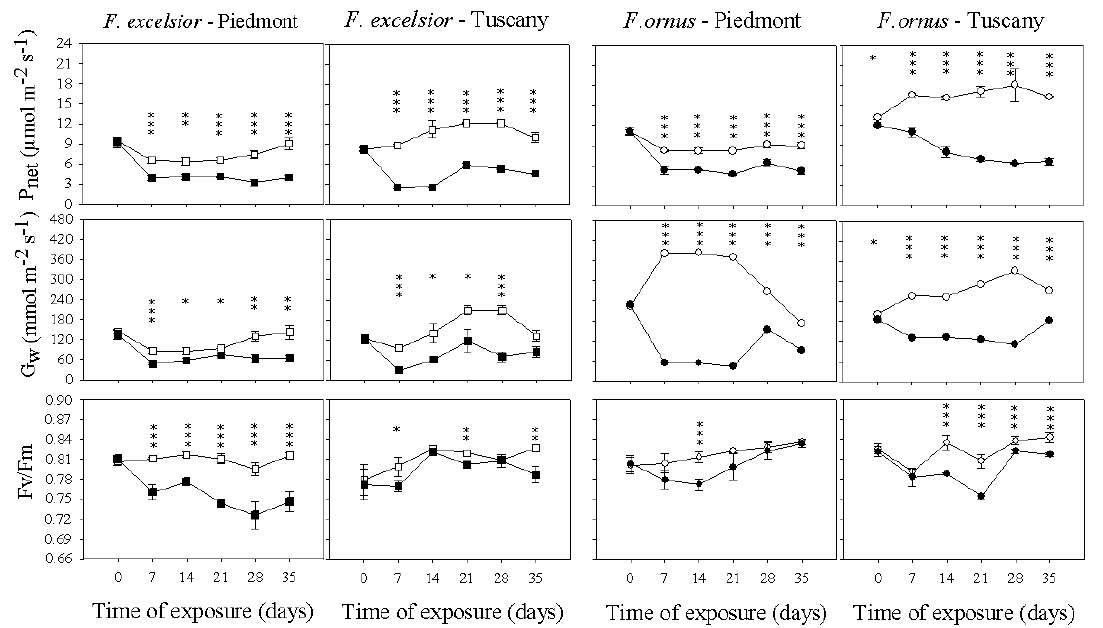
FIGURE 1 . Effects of ozone exposure (150 nmol mol –1 , 8 h day –1 , 35 days) on net photosynthesis (P net ), stomatal conductance to water vapor (G w ), and maximum quantum yield for primary photochemistry (Fv/Fm) in Piedmont and Tuscan provenances of F. excelsior and F. ornus . Values represent means ±S.E. Symbols represent the results of t-test of O 3 exposure. *, p ≤ 0.05; **, p ≤ 0.01; ***, p ≤ 0.001; ns (not significant), p > 0.05; □ , F. excelsior control; ■ , F. excelsior O 3 exposed; ○ , F. ornus control; ● , F. ornus O 3